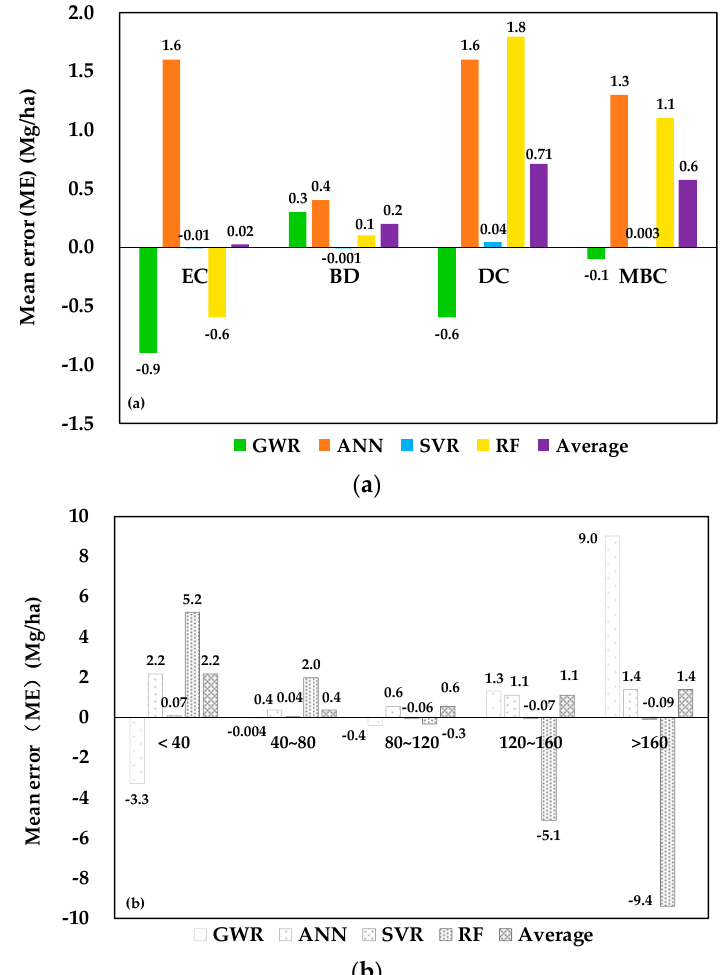
Figure 7. The mean errors of the above-ground biomass predictions for ( a ) different forest types, ( b ) different AGB using geographically weighted regression (GWR), the multi-layer perception neural network (ANN), support vector machines for regression (SVR), and random forests (RF). EC, BD, DC, and MBC represent evergreen coniferous, broadleaved deciduous, deciduous coniferous, and mixed broadleaf-conifer forests, respectively.